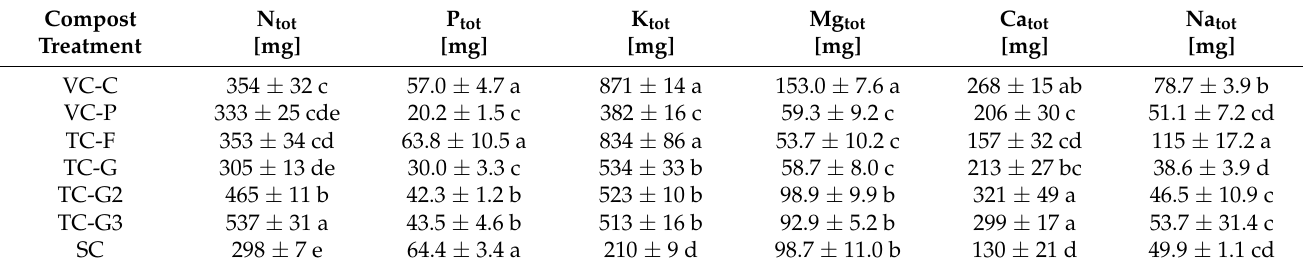
Table 4. Uptake of macronutrients N, P, K, Mg, Ca, and Na in lettuce shoots, expressed as mg per plant shoot (dry matter) (mean ± standard deviation, n = 5). Different letters reflect that means significantly differ from one another (HSD, Tukey test, α = 0.05; n = 5). SC, sand control; TC-F, thermophilic compost from fecal matter; TC-G, thermophilic compost from green waste; TC-G2 and TC-G3, thermophilic compost from green waste with additional N fertilization; VC-C, vermicompost with coir bedding material; VC-P, vermicompost with paperboard bedding